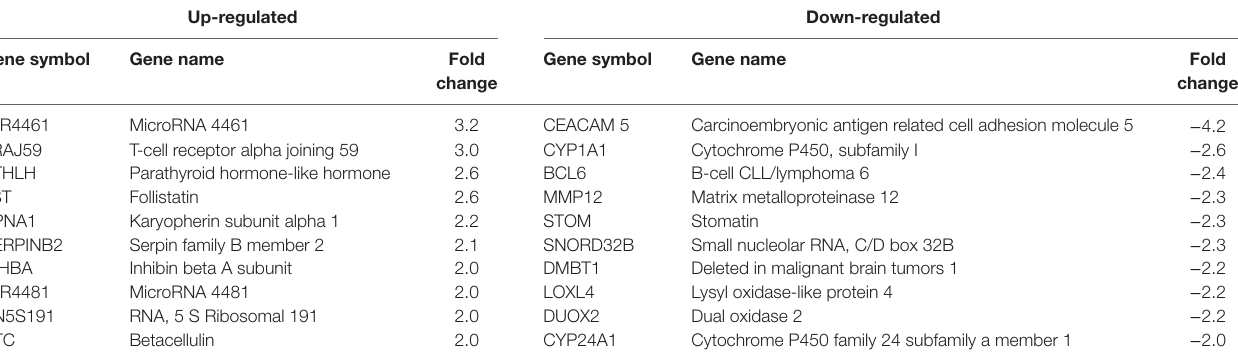
TaBle 3 | HPV11E6 and HPV18E6 shared Top 10 up- and down-regulated genes based on either the extent of up- or downregulation or on their known involvement in cellular transformation.